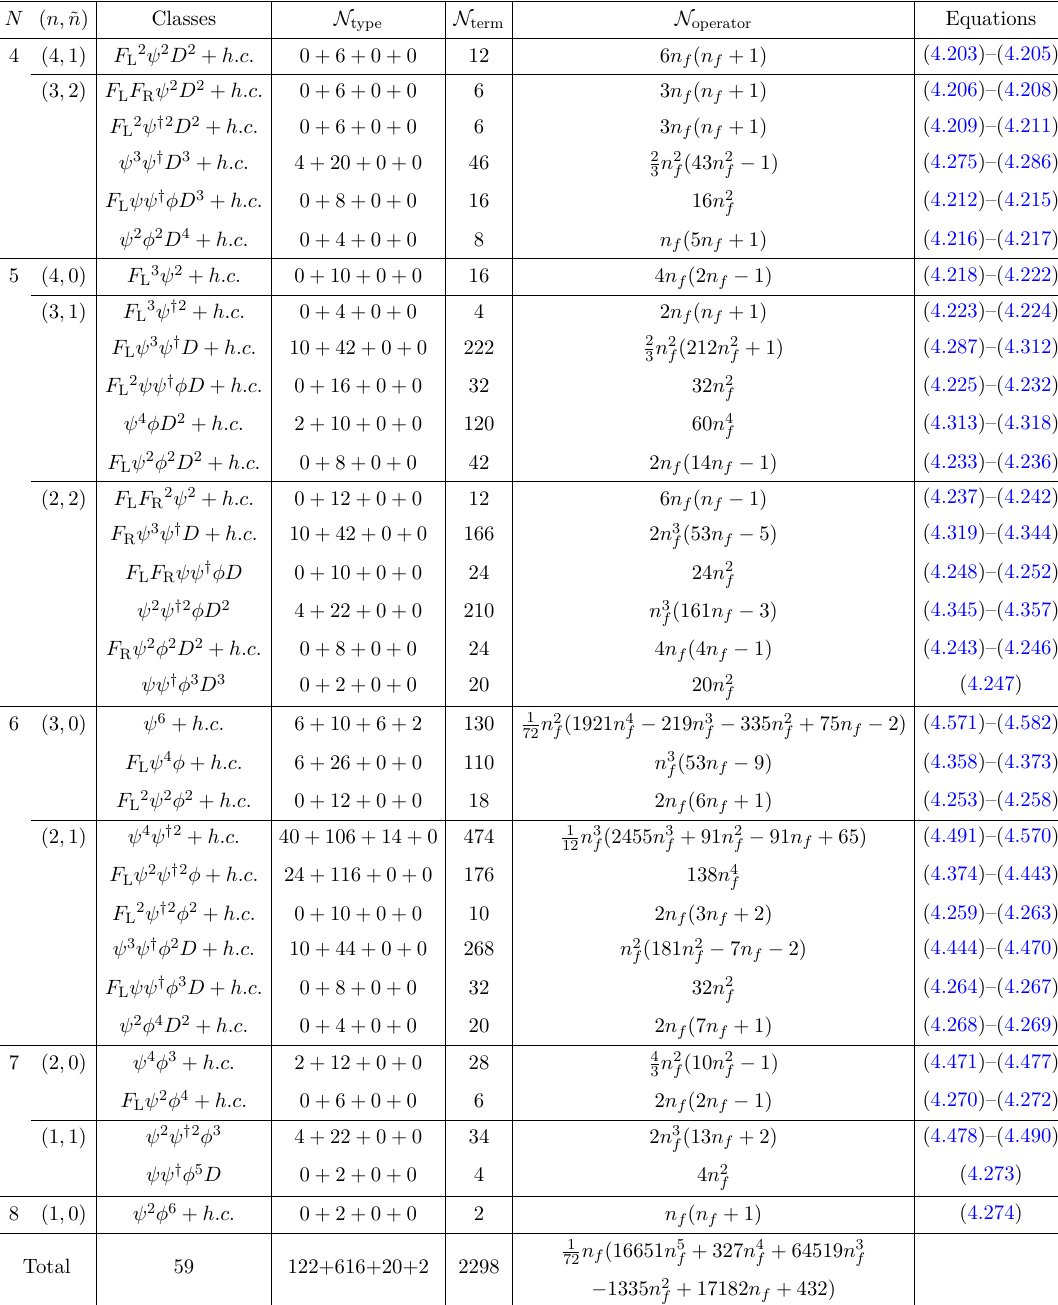
Table 5 . The complete statistics of dimension 9 ν SMEFT operators. The numbers under N type describe the sum of each possible | ∆ L | types/operators with N = N ( | ∆ L | = 1) + N ( | ∆ L |